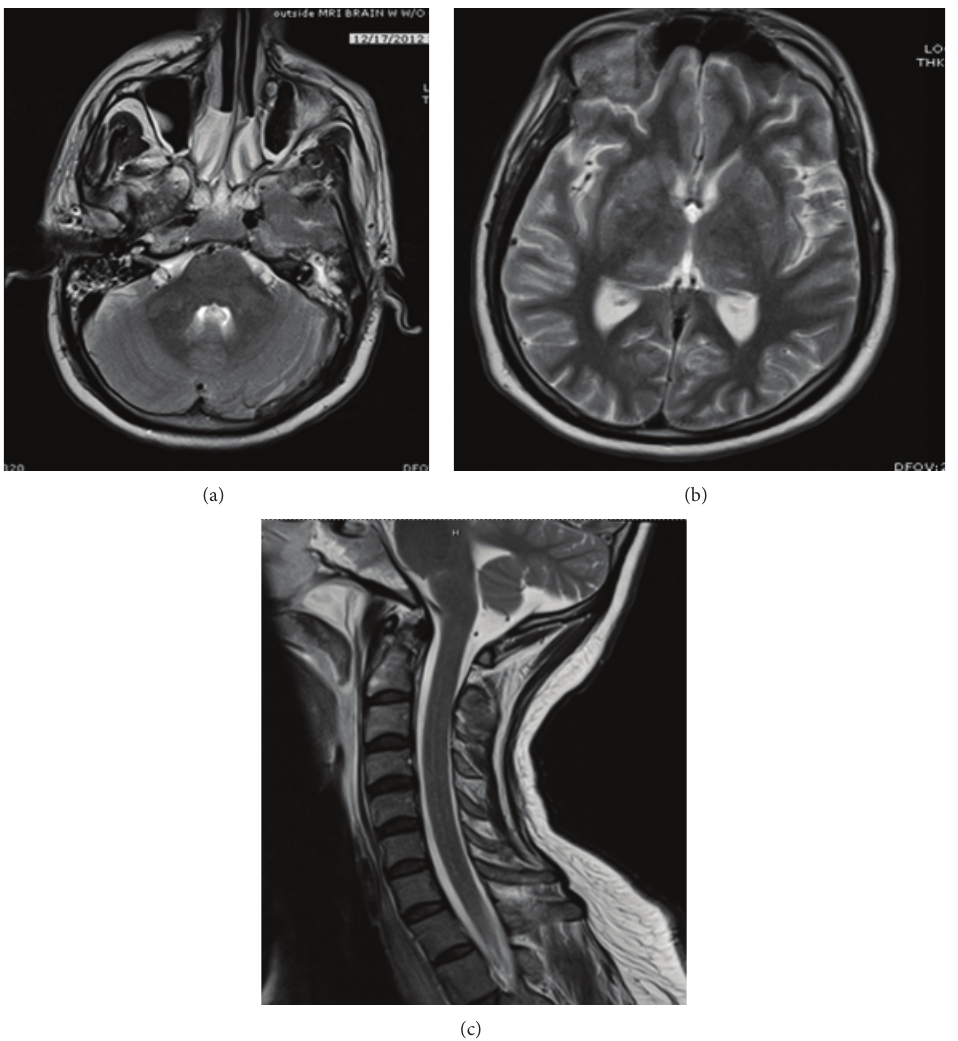
Figure 1: (a) MRI brain showing increased T-2 signal in middle cerebellar peduncles. (b) MRI brain showing increased T-2 signal in bilateral basal ganglia. (c) MRI cervical spine showing mild diffusely increased T-2